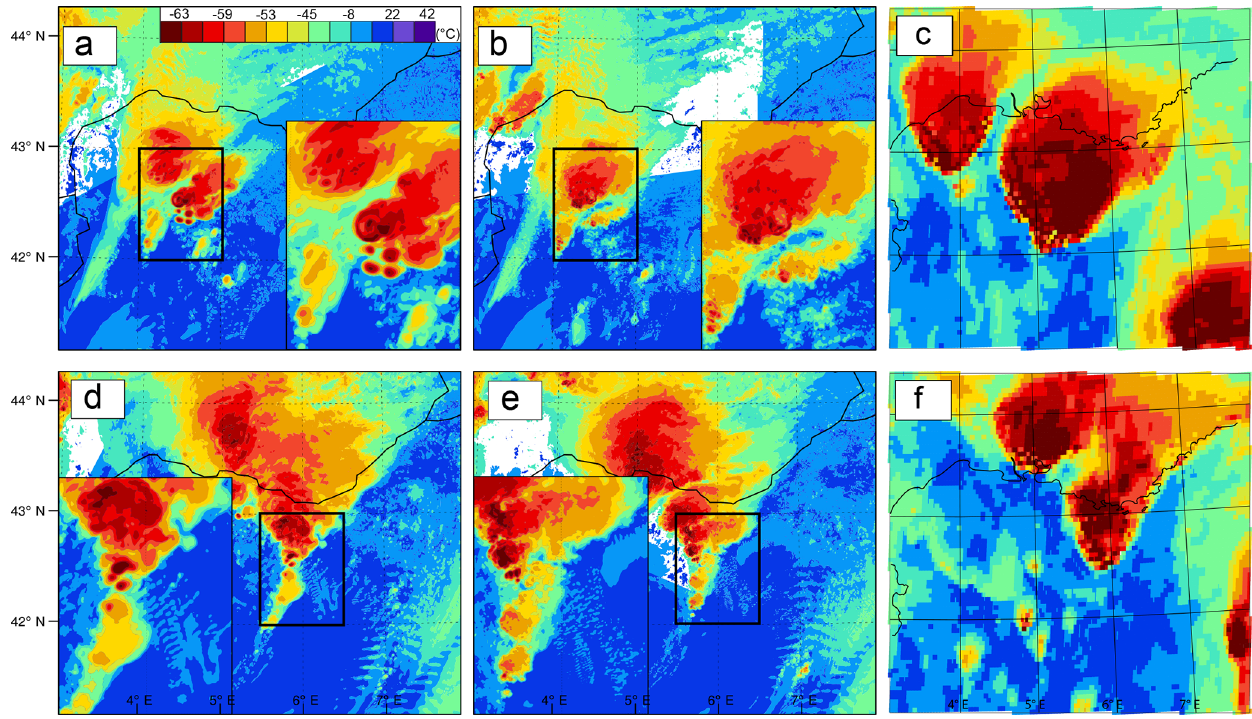
Figure 7. Same as Fig. 6 except for simulated infrared brightness temperature ( ◦